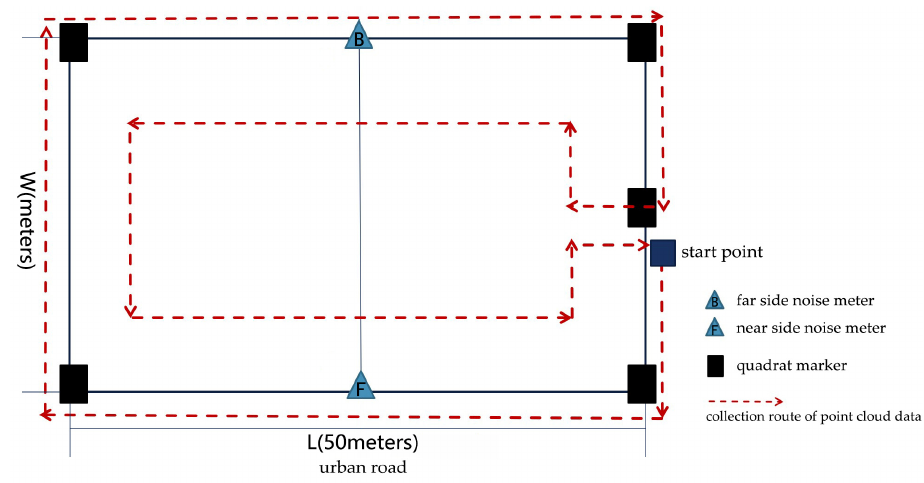
Figure 3. Schematic diagram of quadrat measurement.